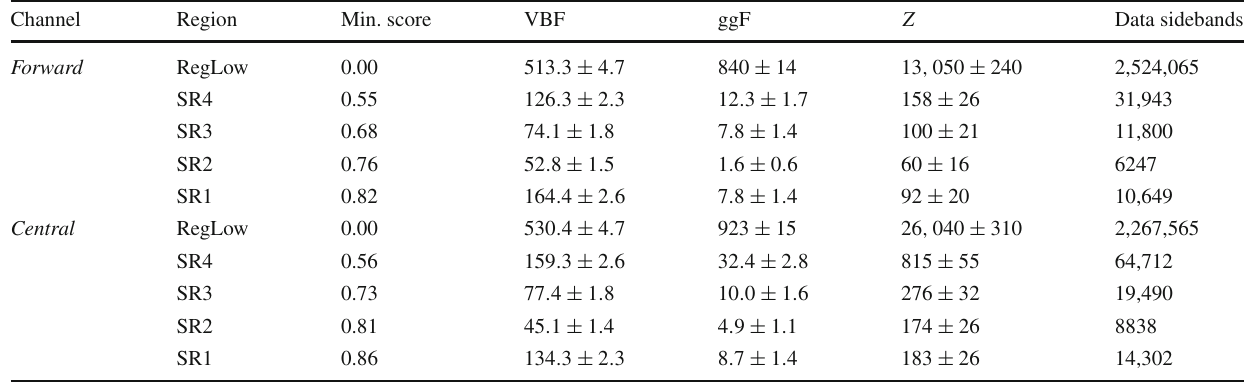
combined data sidebands. Yields for Z event estimates are determined in data as described in Sect. 6. Yields from t ¯ tH and V H events are negligible. Errors are statistical only